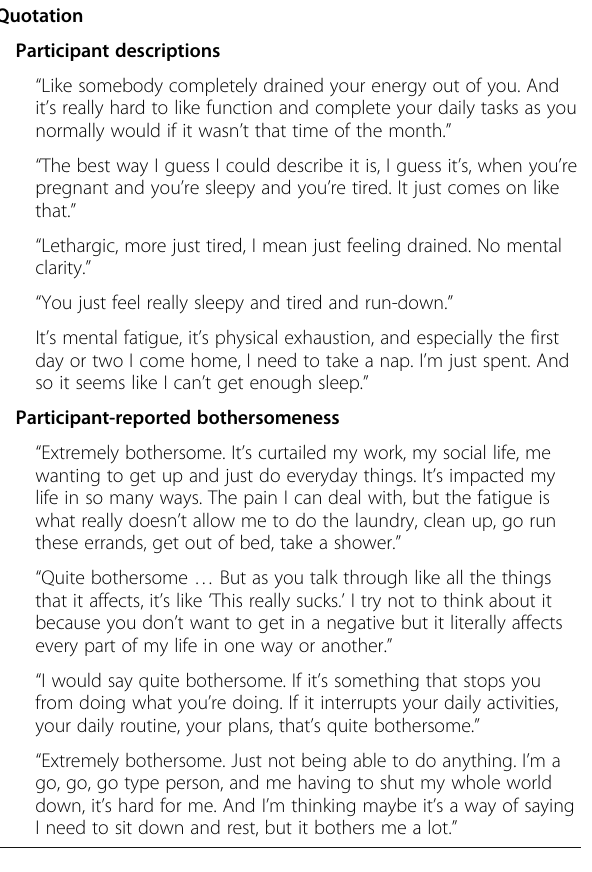
Table 2 Participant Descriptions and Reported Bothersomeness